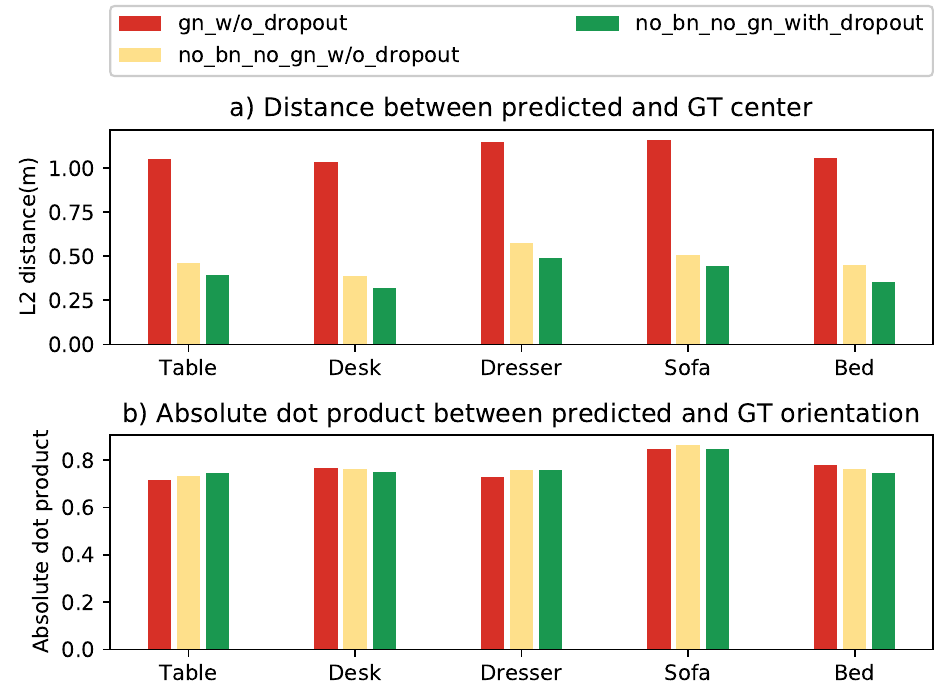
Desk Dresser Sofa Figure 9. Performance comparison of different combinations on using batch normalization (BN), group normalization (GN) and dropout. “gn_w/o_dropout” means using GN without dropout. “no_bn_no_gn_w/o_dropout” means using none. “no_bn_no_gn_with_dropout” means not using BN/GN, however, the dropout is